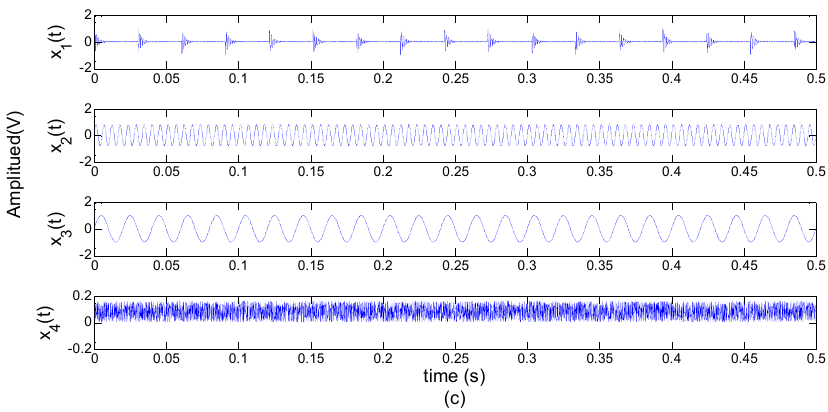
Figure 1. Simulated signal and its components. ( a ) Waveform of the simulated signal; ( b ) its spectrum; ( c ) source components of the simulated signal.